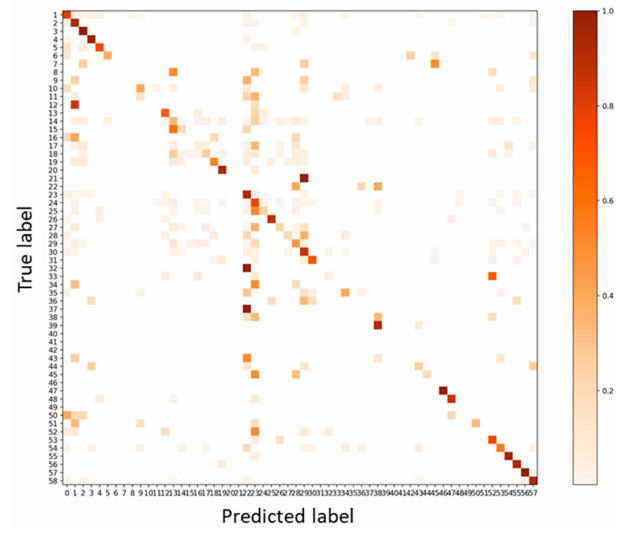
Figure 7. Confusion matrix of random separation dataset: same site and same time. The vertical axis is the ground truth and the horizontal axis is the model prediction. The number in each cell indicates the number of classified images; each cell is colored according to the percentage of the number of images in each class. The model yielded a Kappa score of 0.72.